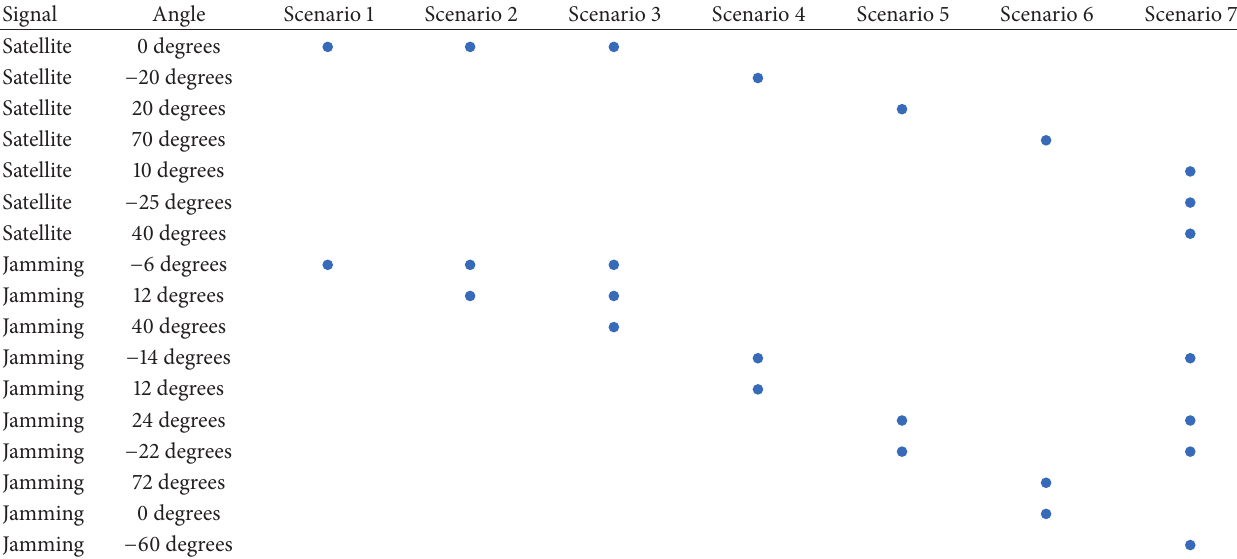
indicates the selected satellite signal or jamming signal.